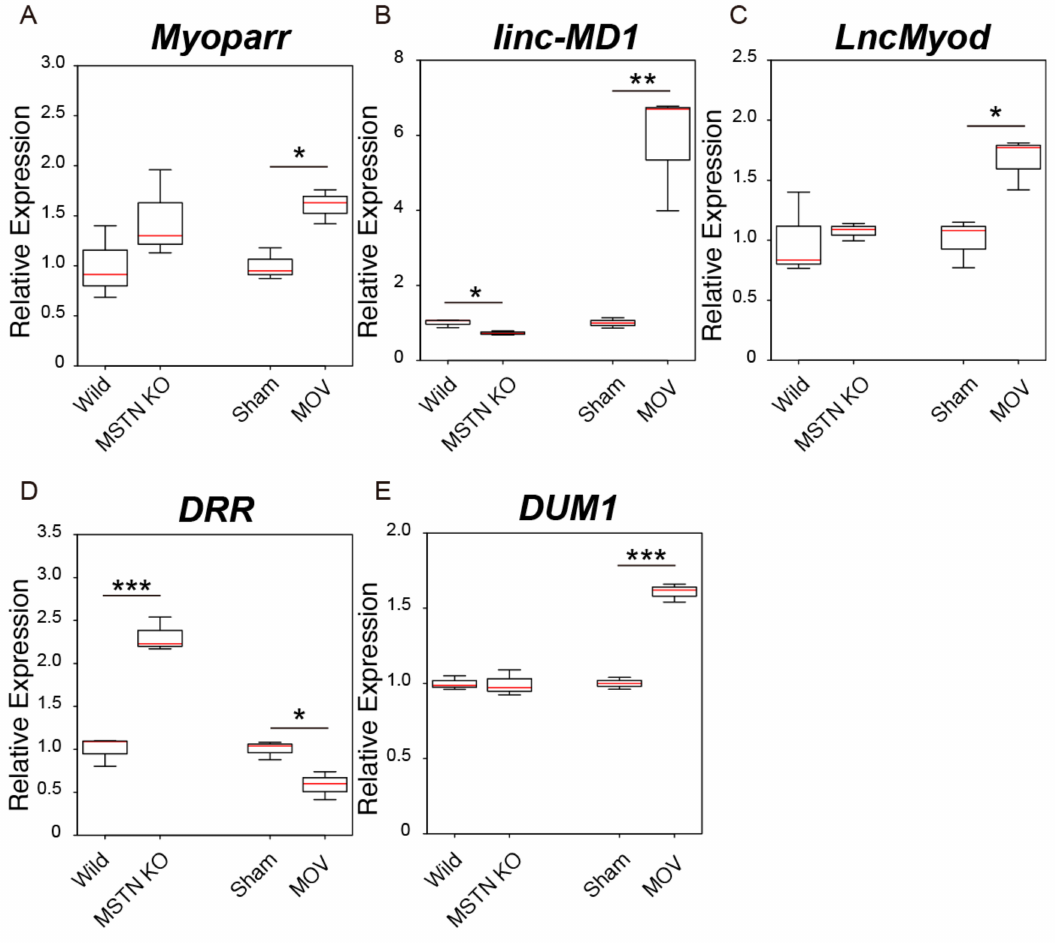
Figure 4. Changes in the expression levels of skeletal muscle di ff erentiation-related lncRNAs in skeletal muscle hypertrophy conditions. ( A – E ) Box-and-whisker plots showing the results of quantitative RT-PCR (qRT-PCR) for Myoparr ( A ), linc-MD1 ( B ), LncMyod ( C ), DRR ( D ), and DUM1 ( E ) expression in two muscle hypertrophy conditions. Wild; tibialis anterior (TA) muscles of control C57BL / 6J mice. MSTN KO; TA muscles of C57BL / 6J-background myostatin knockout mice. Sham; plantaris muscles of sham-operated C57BL / 6J mice. MOV; plantaris muscles of mechanical overload (MOV)-operated C57BL / 6J mice. qRT-PCR data were normalized to Rpl26 expression and shown as relative expression. n = 3 per group. * p < 0.05. ** p < 0.01. *** p <